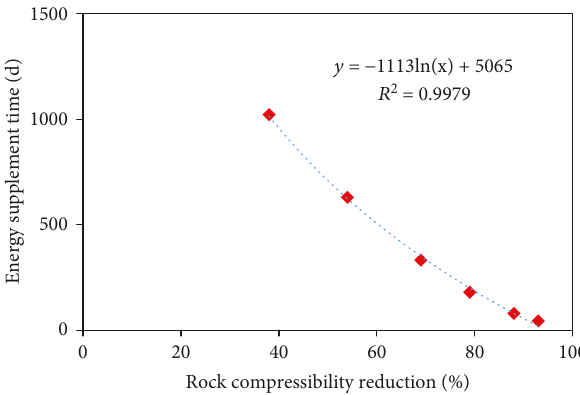
Figure 7: Energy supplement time vs rock compressibility